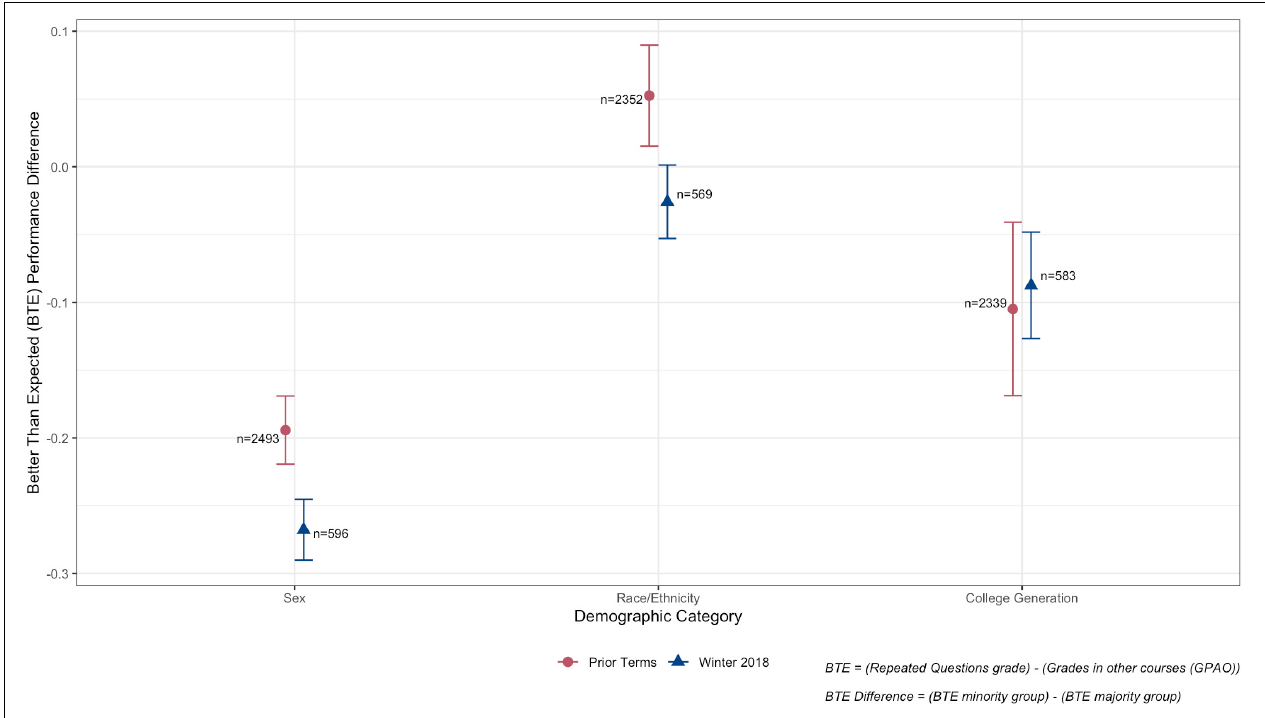
FIGURE 3 | Difference in BTE scores for each comparison